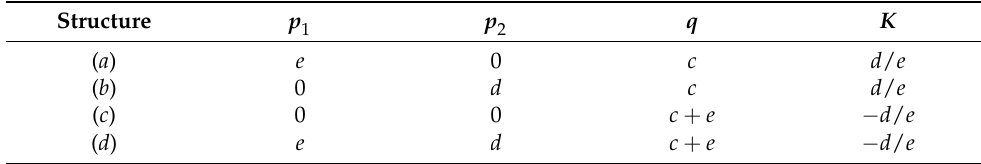
Table 2. Values of triangular–triangular intermediate